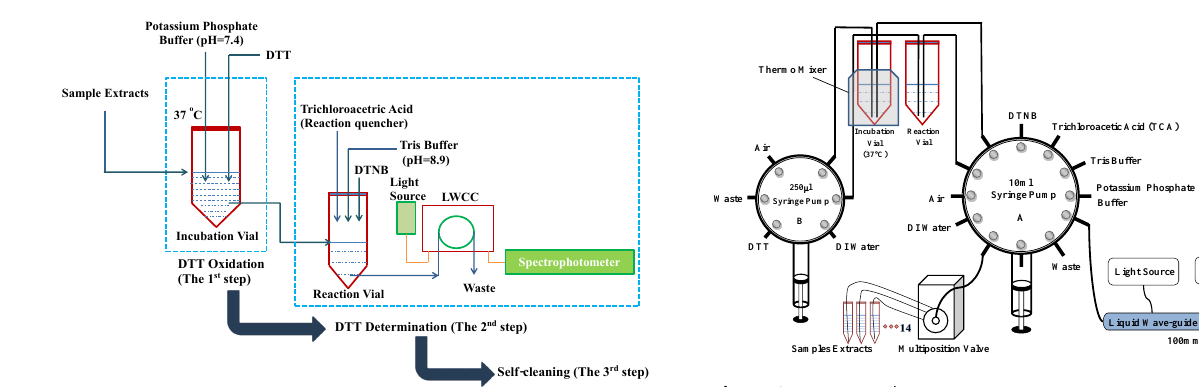
Figure 2. Automated system